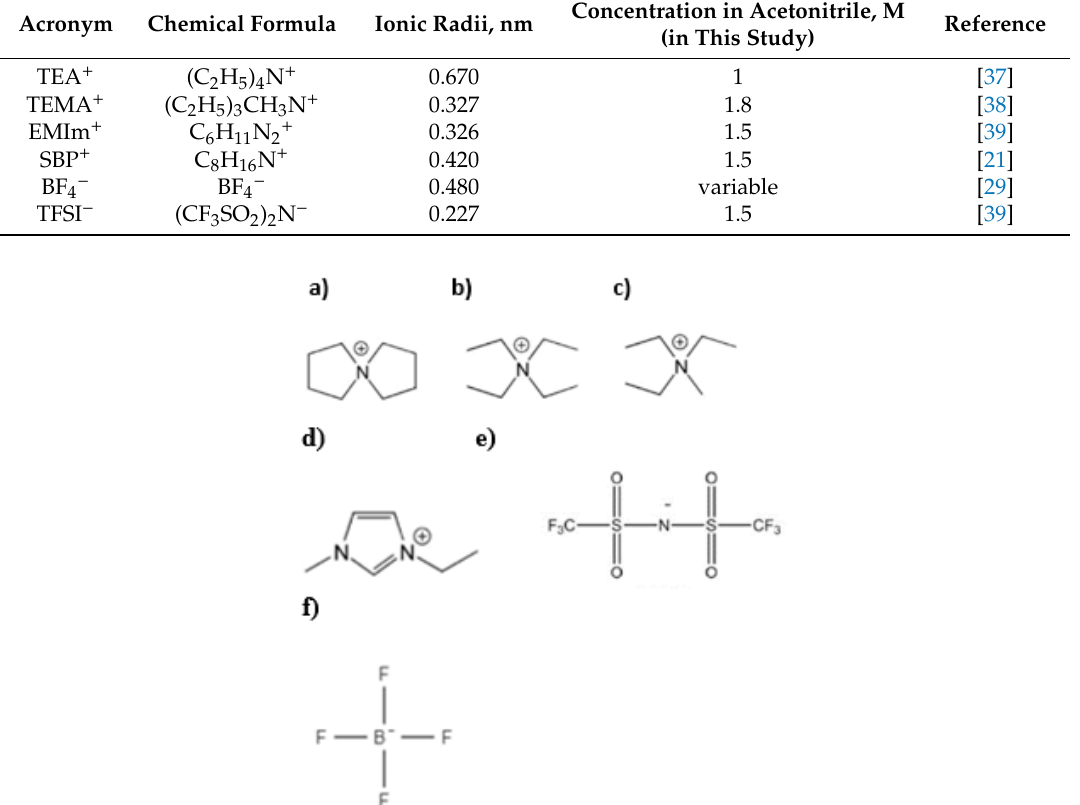
Table 1. Porosity characteristics of CDC particles.